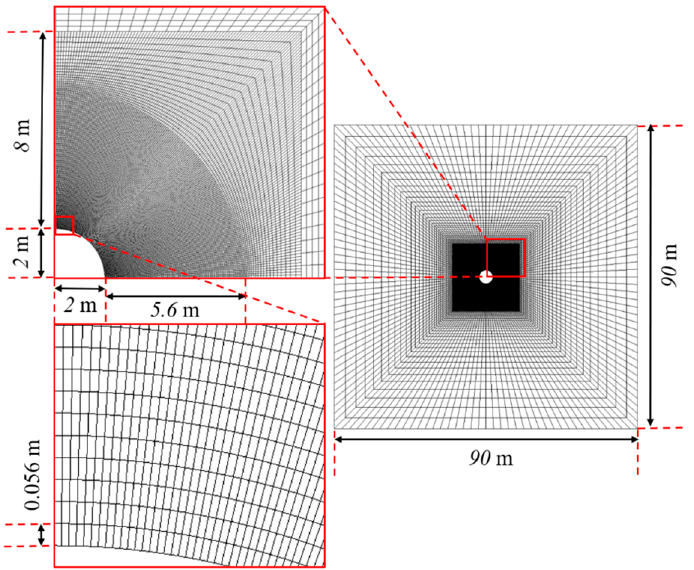
Figure 8. The front view of the model and its meshing system (no discretization in thickness).